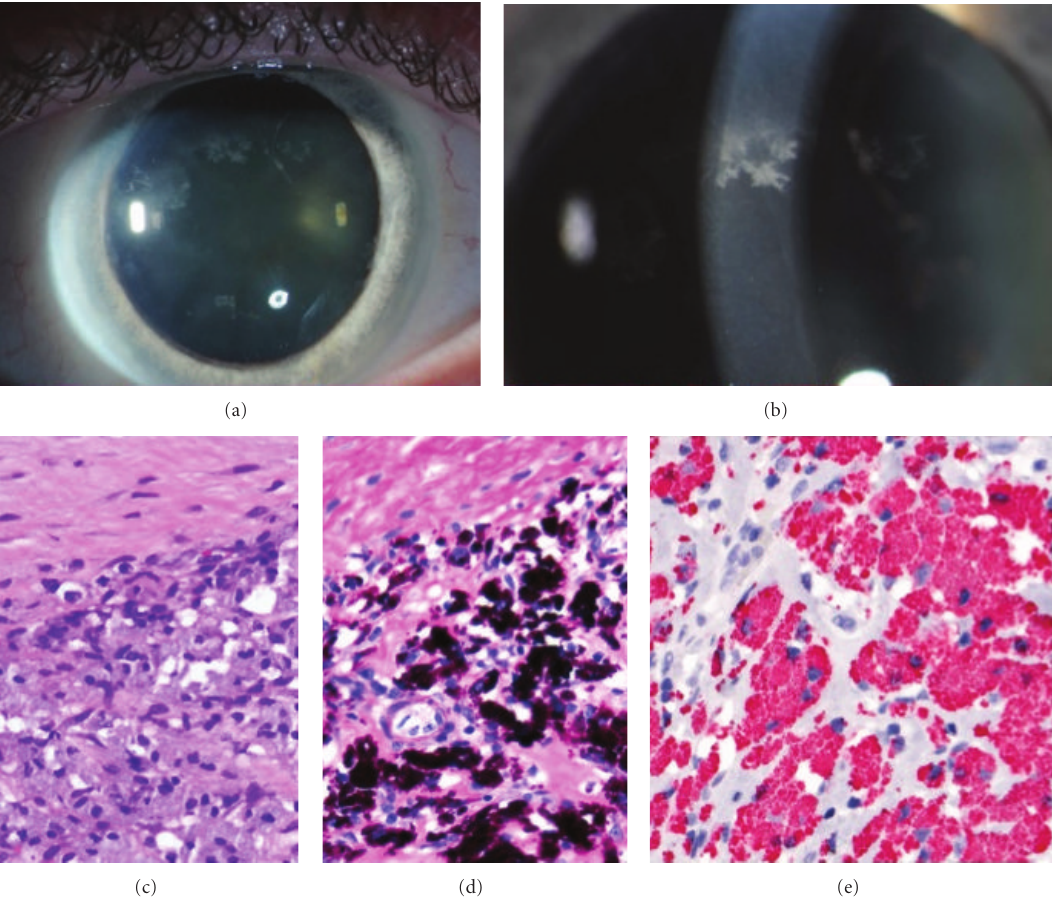
Figure 2: Three months after initial presentation, crystalline deposits are evident at the level of the corneal endothelium (a)-(b). Several months later, numerous foamy macrophages were identified on hematoxylin and eosin (H&E) stained aortic valve tissue (c) that stained robustly with periodic acid-Schi ff diastase (d). The presence of organisms was confirmed by polyclonal anti- T. whipplei antibody (e). ((c)– (e)) courtesy of The Centers for Disease Control, Atlanta, GA.